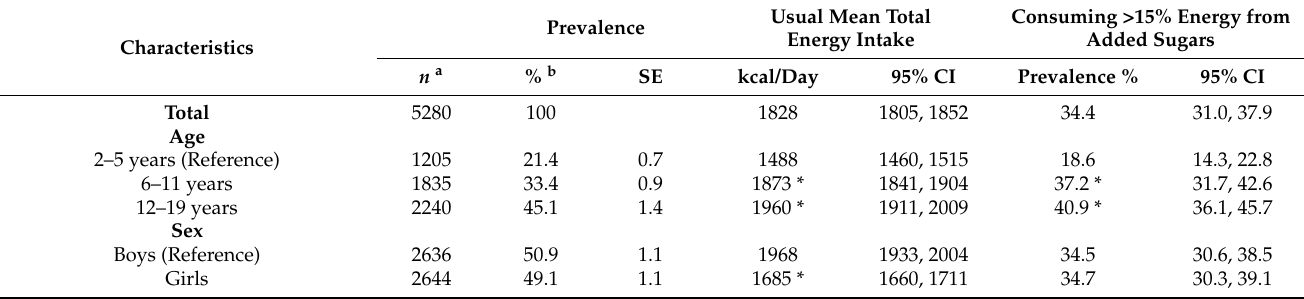
Table 1. Characteristics of the survey population and their daily mean total energy intake and participants consuming over 15% energy from added sugars (i.e., high consumers) among US children and adolescents aged 2–19 years, NHANES 2015–2018, based on usual intake